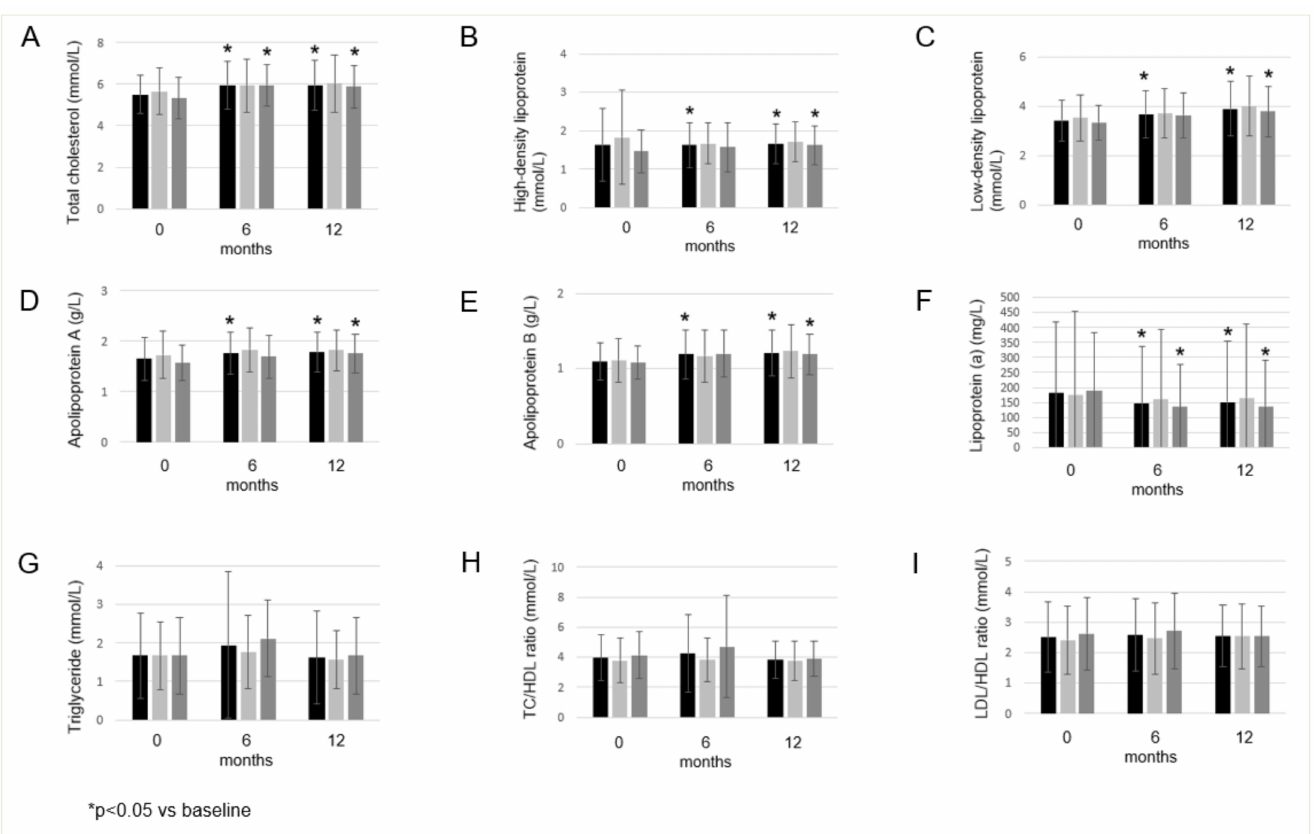
Figure 1. Effects of one-year tofacitinib therapy on total cholesterol ( A ), high-density lipoprotein ( B ), low-density lipoprotein ( C ), apolipoprotein A ( D ), apolipoprotein B ( E ), lipoprotein(a) ( F ) and triglyceride ( G ) levels, as well as TC/HDL ( H ) and LDL/HDL ratio ( I ) in the entire RA cohort, 5 mg bid and 10 mg bid treatment arm, respectively, at baseline, and 6 and 12 months of treatment. Asterisks indicate significant changes ( p <